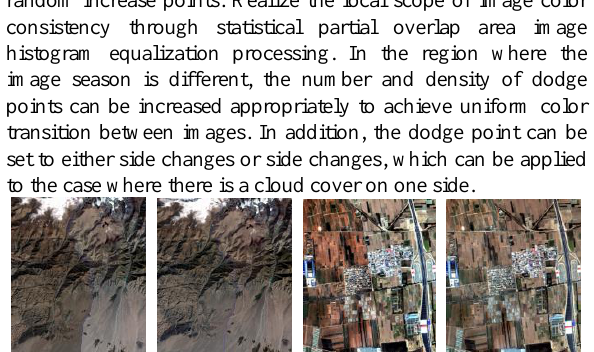
Above reflect the changes of the urban area before and after the adjustment histogram, figure 3 before the adjustment of image gray scale average of 148 and 362 respectively, difference is gap decreased